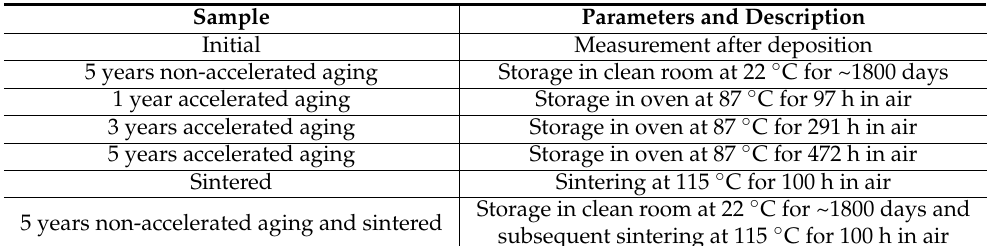
Table 2. Overview of the samples used for investigation of the aging impact on the mechanical properties. Sample Parameters and Description